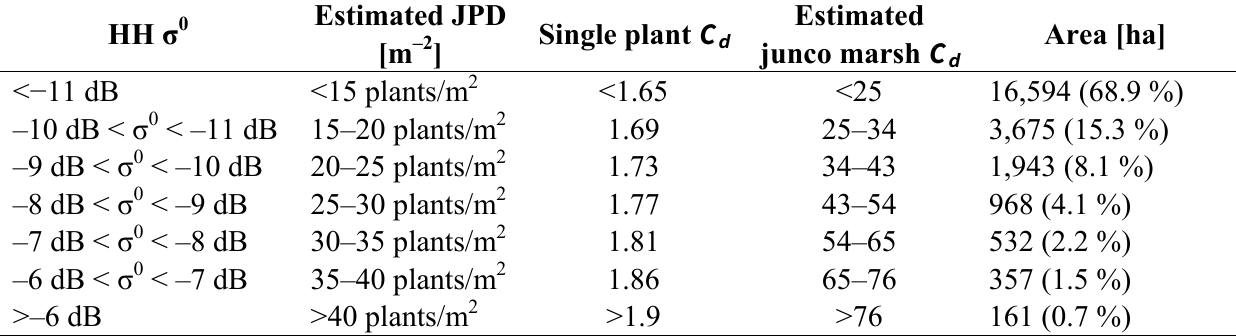
Table 3. Segmentation proposed to derive JPD from σ 0 values and the corresponding single plant and marsh drag